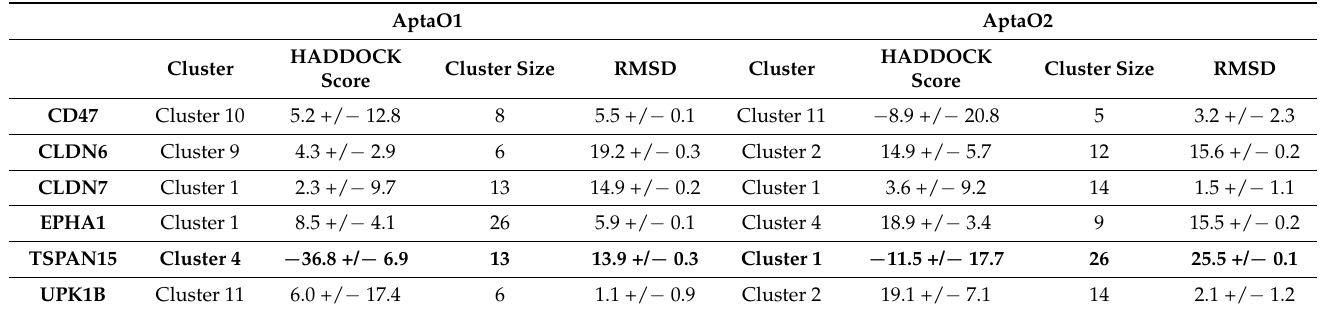
Table 2. Molecular docking parameters of possible targets in OvCar-3